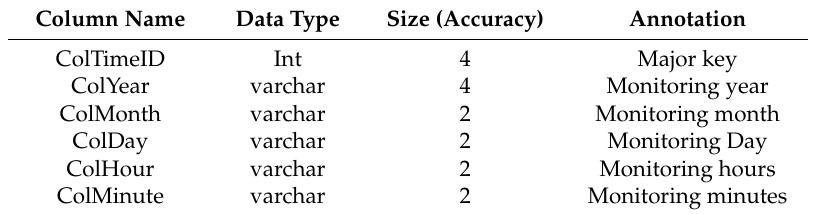
Table 5. Collection of time dimension table properties.